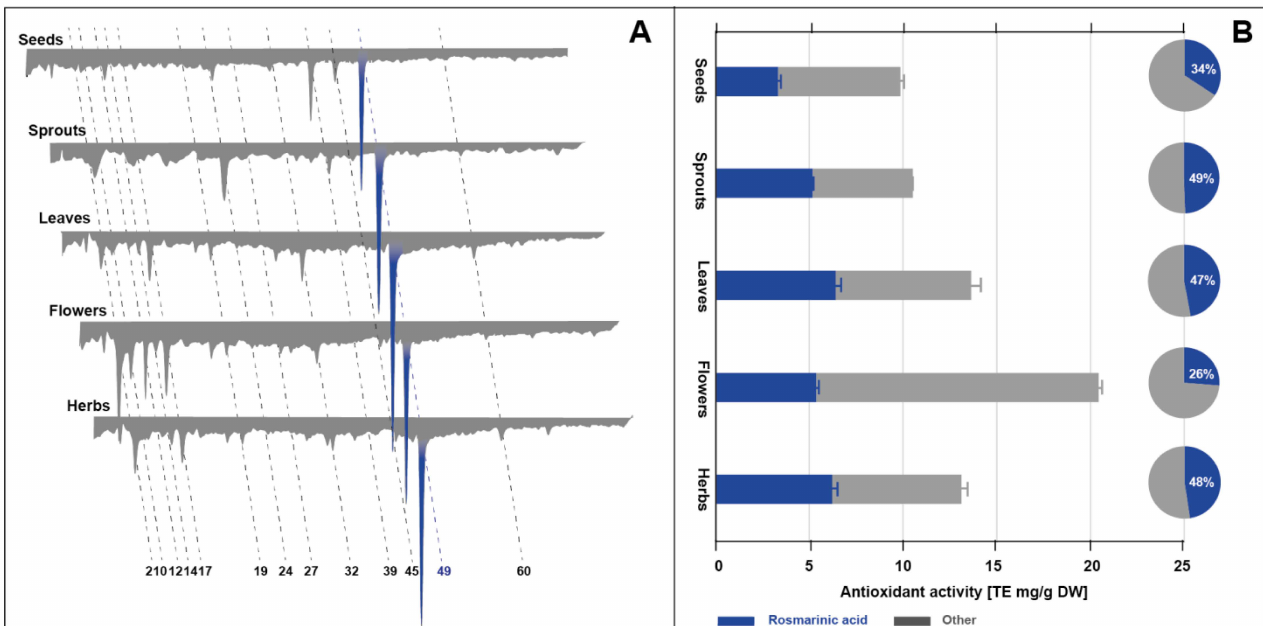
Figure 2. HPLC antioxidant profiles of seed, sprout, leaf, flower and herb extracts of S. hispanica registered at 734 nm after post-column derivatization with ABTS reagent ( A ) set with bar and pie charts reporting, respectively, antioxidant activity expressed as Trolox equivalents and the percentage contribution to the total antioxidant activity of rosmarinic acid and other antioxidants present in extracts ( B ). For identity of peaks, see Table 1.